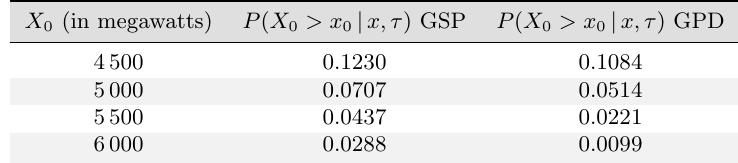
Table 2: A selection of the posterior predictive tail